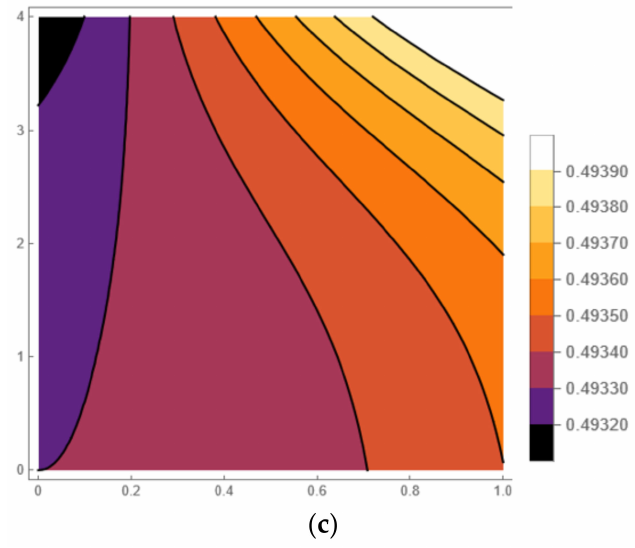
Figure 2. The contour graph of the approximate solutions ( a ) δ ( ξ , τ ) , ( b ) φ ( ξ , τ ) , and ( c ) ψ ( ξ , τ ) for